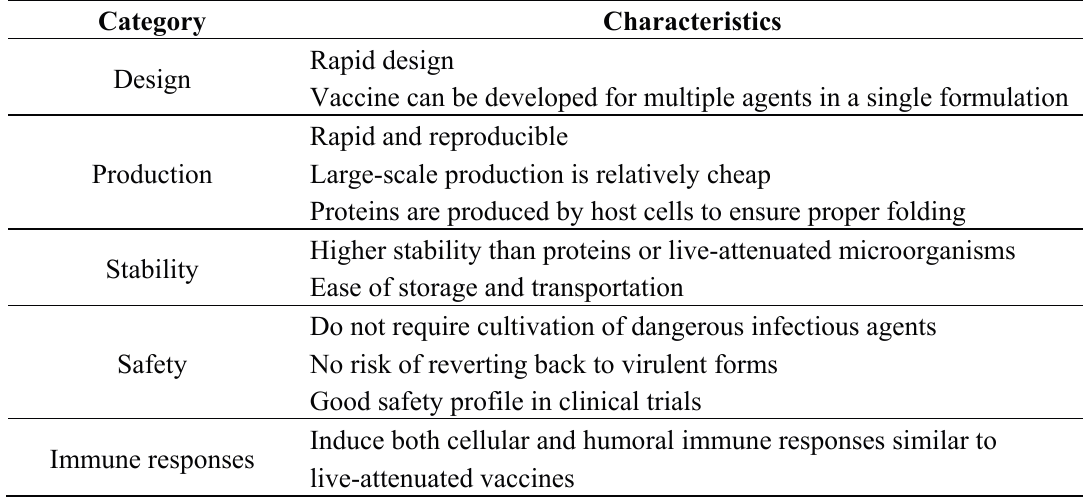
Table 1. Advantages of DNA vaccines compared to conventional